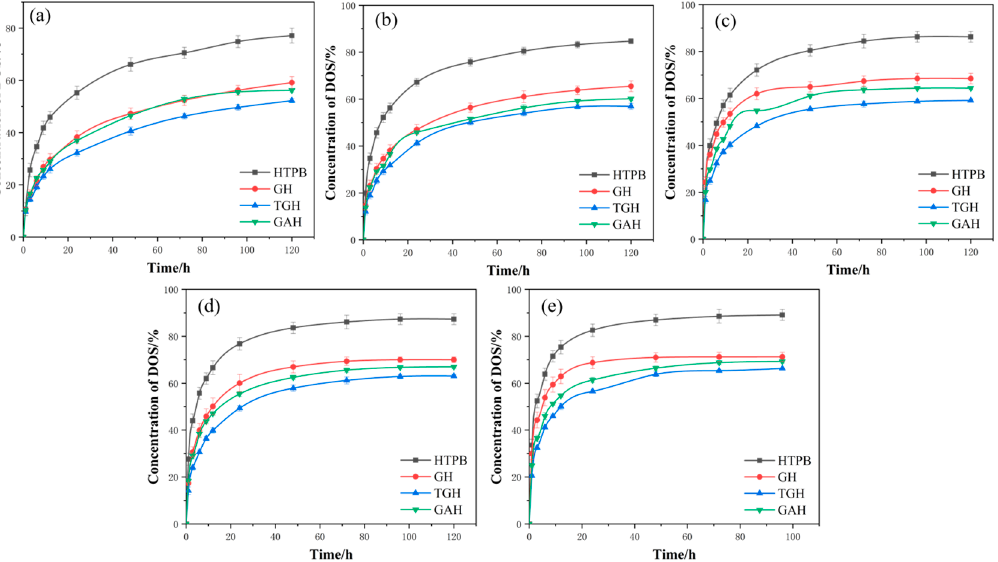
Figure 8. Time-varying DOS concentrations at various temperatures in different liners by the im- pregnation method. ( a ) 30 °C; ( b ) 40 °C; ( c ) 50 °C; ( d ) 60 °C; ( e ) 70 °C. nation method. ( a ) 30 ◦ C; ( b ) 40 ◦ C; ( c ) 50 ◦ C; ( d ) 60 ◦ C; ( e ) 70 ◦